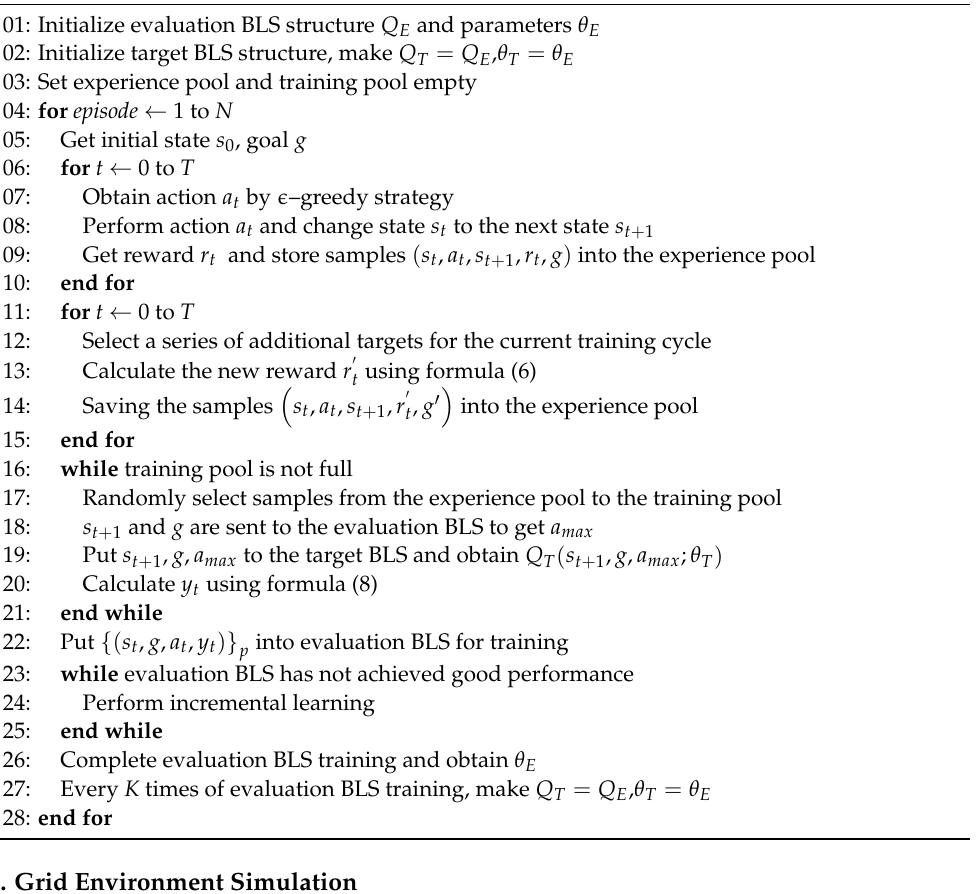
Algorithm 1: DBRL-HER